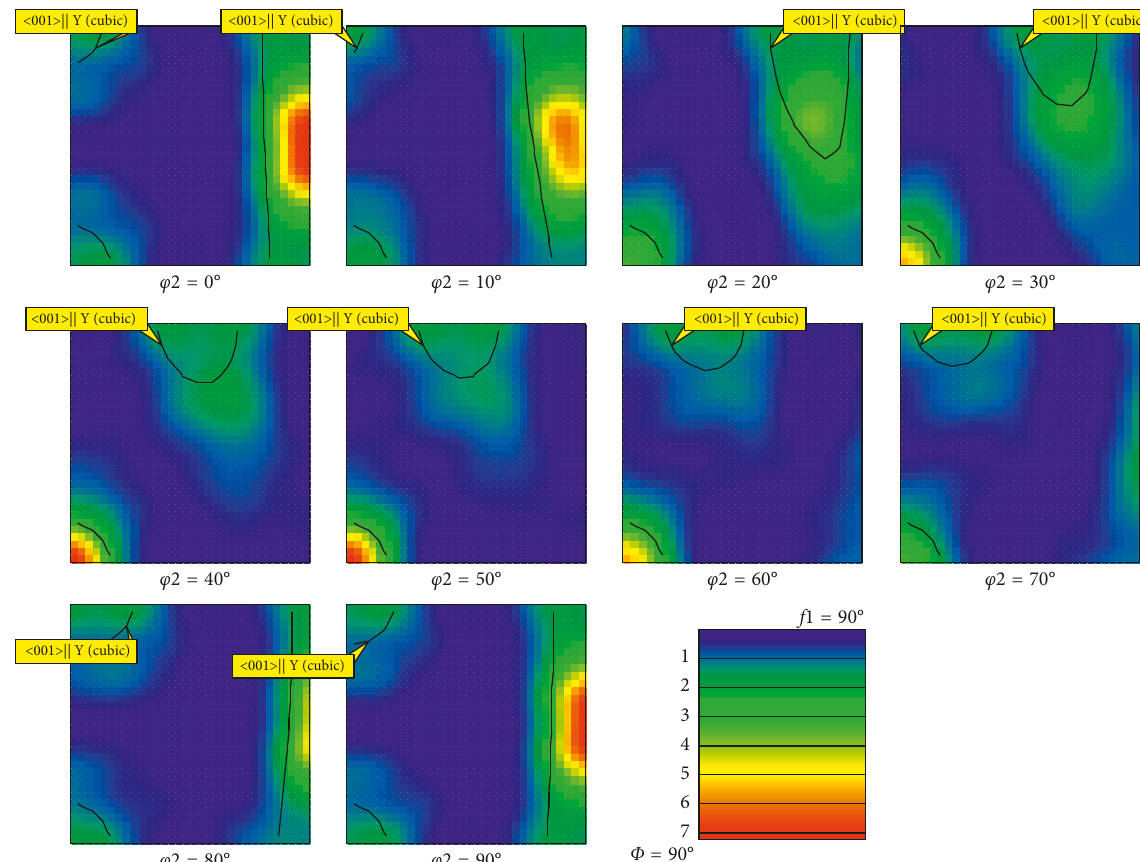
Figure 12: ODF sections of the scanned area. The boundaries of different ϕ 2